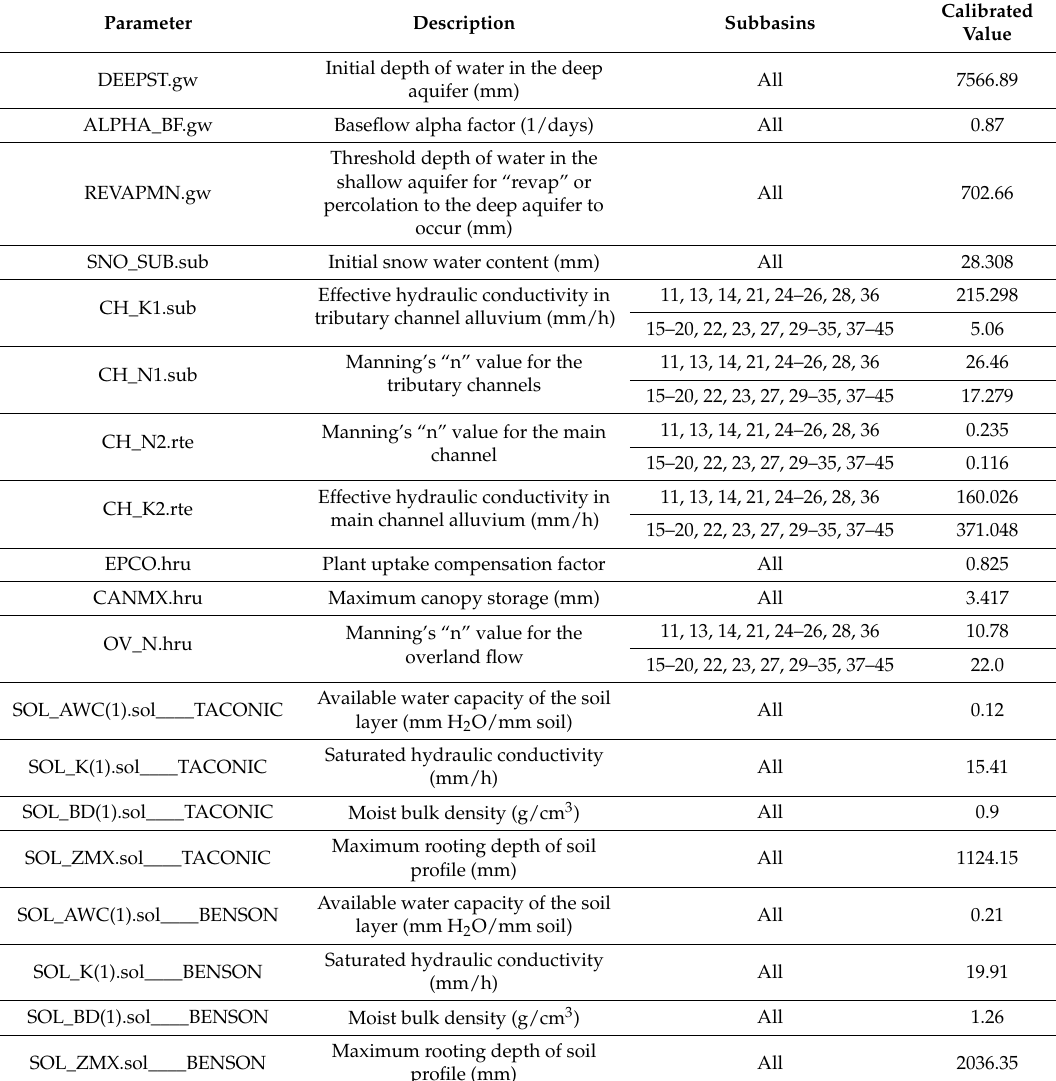
Table 4. The calibrated values for parameters affecting streamflow in the Mahabad Dam